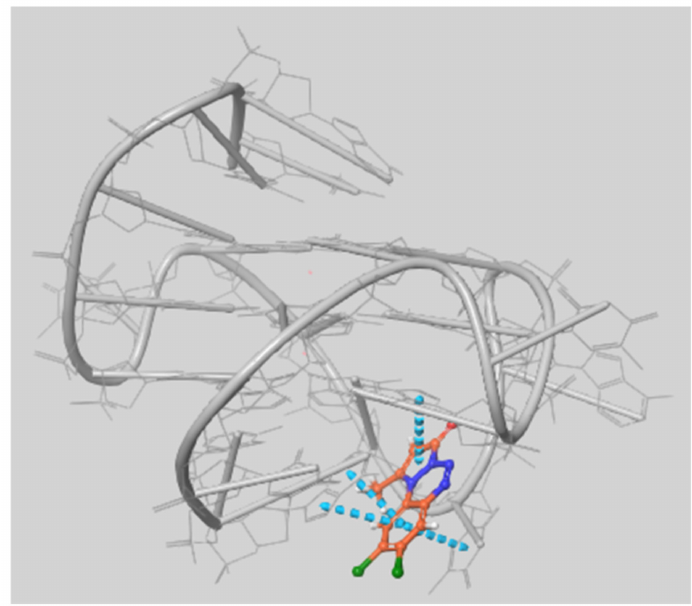
Figure 11. Pose observed at the 3 (cid:48) end of the quadruplex in the ensemble docking of 8,9-di-Cl on the G-quadruplex conformations extracted from the Molecular Dynamics simulations at 350 K of the system